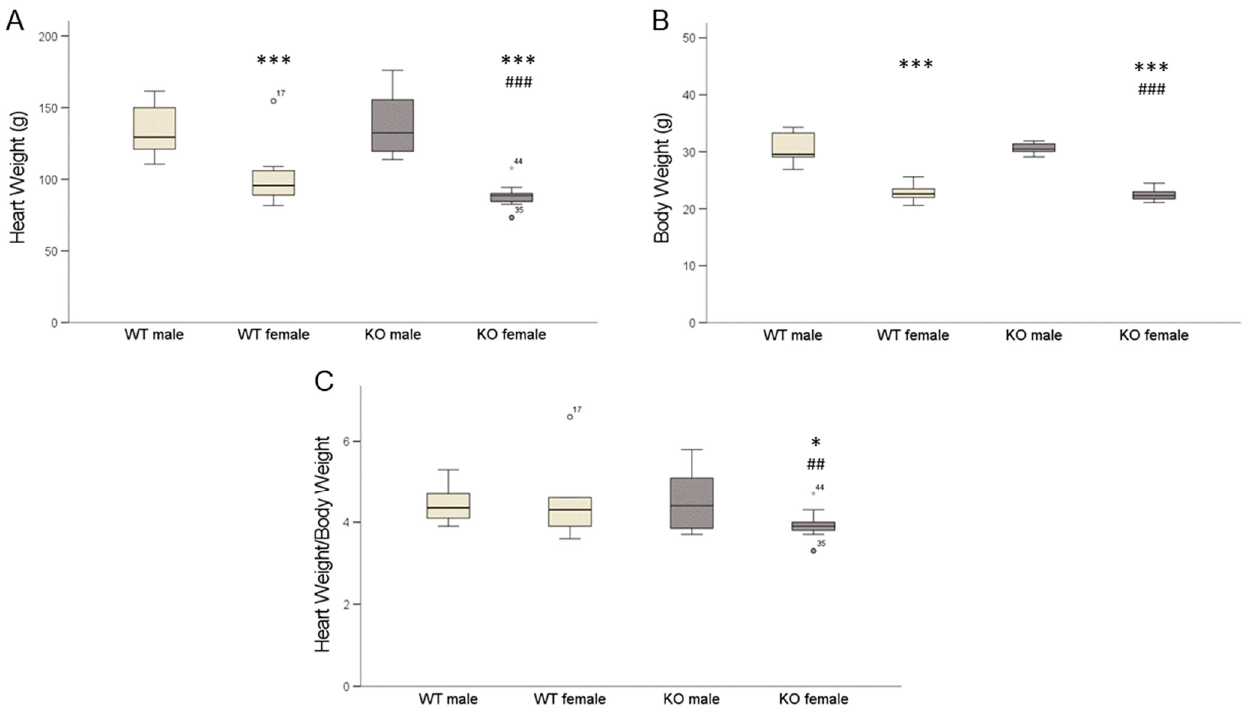
Figure 5. Heart weight (HW) and body weight (BW) as well as HW/BW ratios of mice. Female mice had reduced heart weight ( A ), *** p < 0.001 male vs. female and ### p < 0.001 WT male vs. KO female, Student’s t -test; two-way ANOVA: sex p < 0.001. Female mice had reduced body weight ( B ) compared to male mice, *** p < 0.001 male vs. female, ### p < 0.001 WT male vs. KO female, Student’s t -test; two-way ANOVA: sex p < 0.001. HW/BW ratios ( C ) were similar in WT males and females as well as in male cardiomyocyte-specific knockout (KO) mice, while in female KO mice HW/BW ratio was reduced, * p < 0.05 KO male vs. KO female and ## p < 0.01 WT male vs. KO female, Student’s t -test. Two-way ANOVA: sex * genotype p = 0.088. (WT male n = 14; WT female n = 9; KO male n = 11; KO female n = 11). Data are represented as box plots expressing median, 25% and 75 % quartiles, upper and lower whisker and outliers ( ○, ) . Table 1. Plasma 17 β estradiol levels in WT and MAO-B KO mice. WT and MAO-B KO hearts were exposed to ischemia for 45 min and reperfusion for 120 min. Plasma samples were collected and 17 β estradiol levels determined. * p < 0.05 WT male vs. WT female, ## p < 0.01 WT male vs. MAO-B KO male and female, Student’s t -test. Two-way ANOVA: genotype p = 0.005; sex p = 0.161.